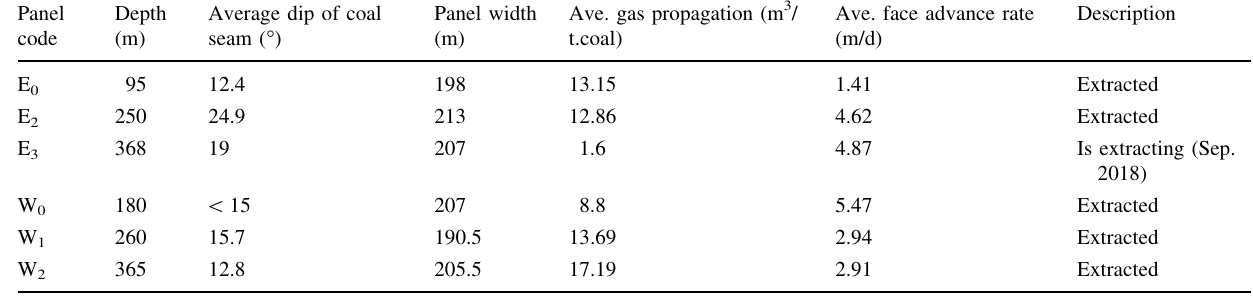
Table 2 Information about considered panels of Parvadeh-I coal mine Panel code